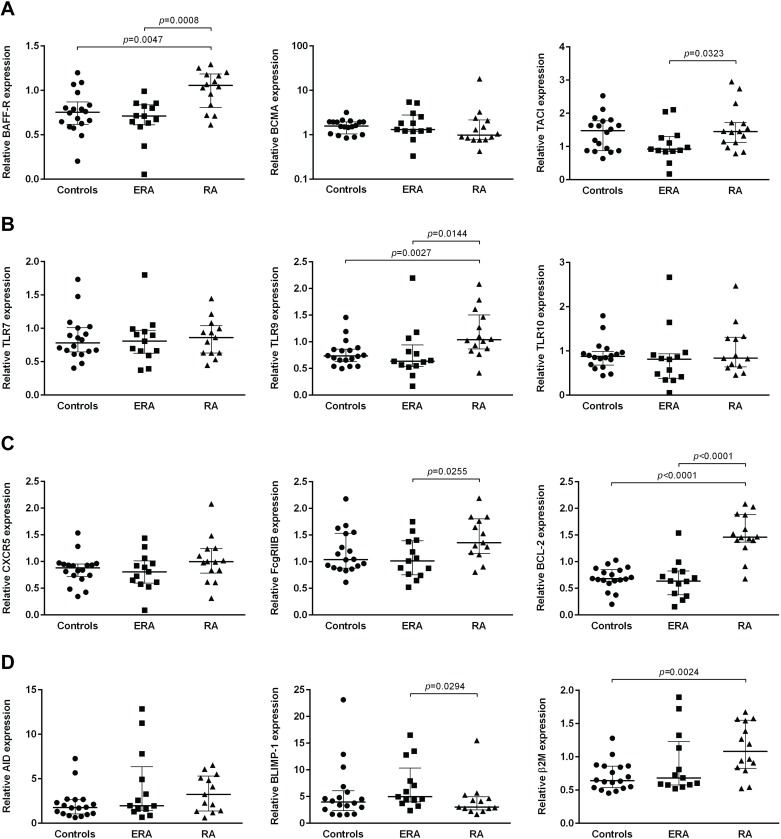
Changes in B-cell gene expression levels occur in rheumatoid arthritis, but no effect of TNF-inhibitors and tocilizumab treatment is observed.The expression of a group of genes related with B-cell activation through B-cell activating factor receptors (BAFF-R, BCMA, TACI) (A); toll-like receptors (TLR7, TLR9, TLR10) (B); chemotaxis (CXCR5), inhibition (FcgRIIB), apoptosis (BCL-2) (C); class-switching (AID), plasma cell differentiation (BLIMP-1) and cellular activation (β2M) (D) was analyzed on isolated B-cells by real time PCR in early RA (ERA) and established RA. The effect of TNF-inhibitors and tocilizumab treatment on B-cell gene expression was assessed in established RA patients at baseline and after an average of 8 months of treatment. Lines represent median values with interquartile range. Differences were considered statistically significant for p<0.05 (non-parametric Mann-Whitney test).